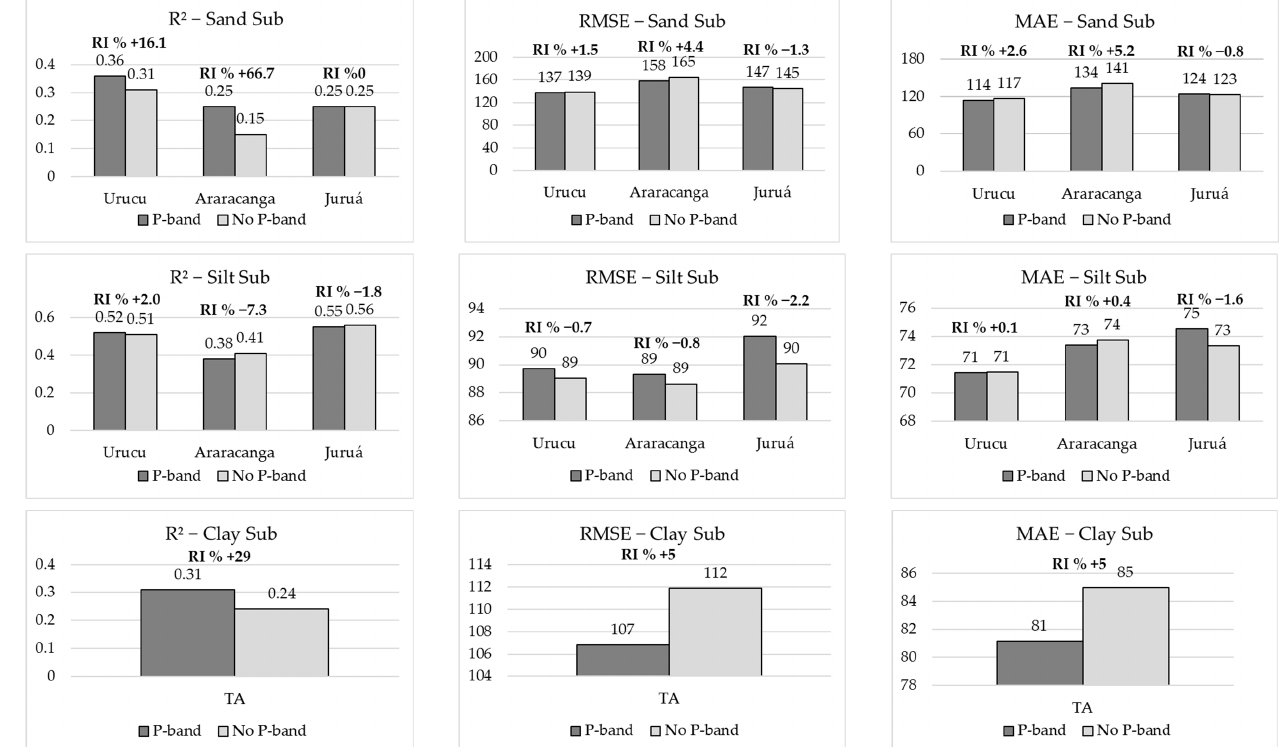
Figure 8. Accuracy with and without radar P-band for subsurface sand, silt, and clay prediction with the best model and approach.